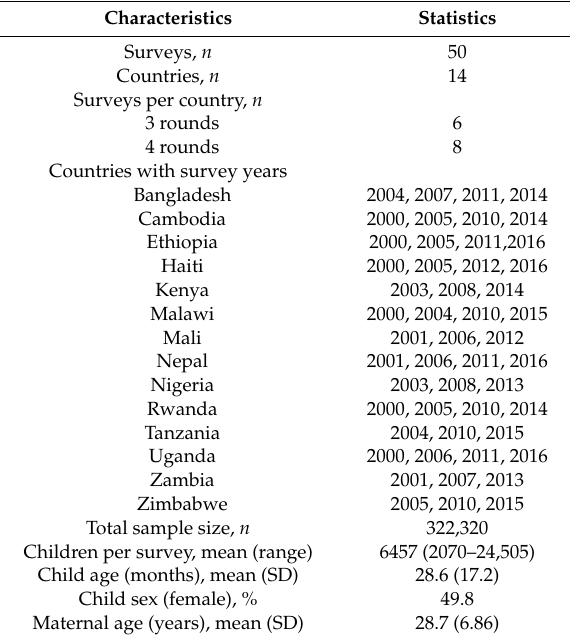
Table 2. Characteristics of included Demographic and Health Surveys.